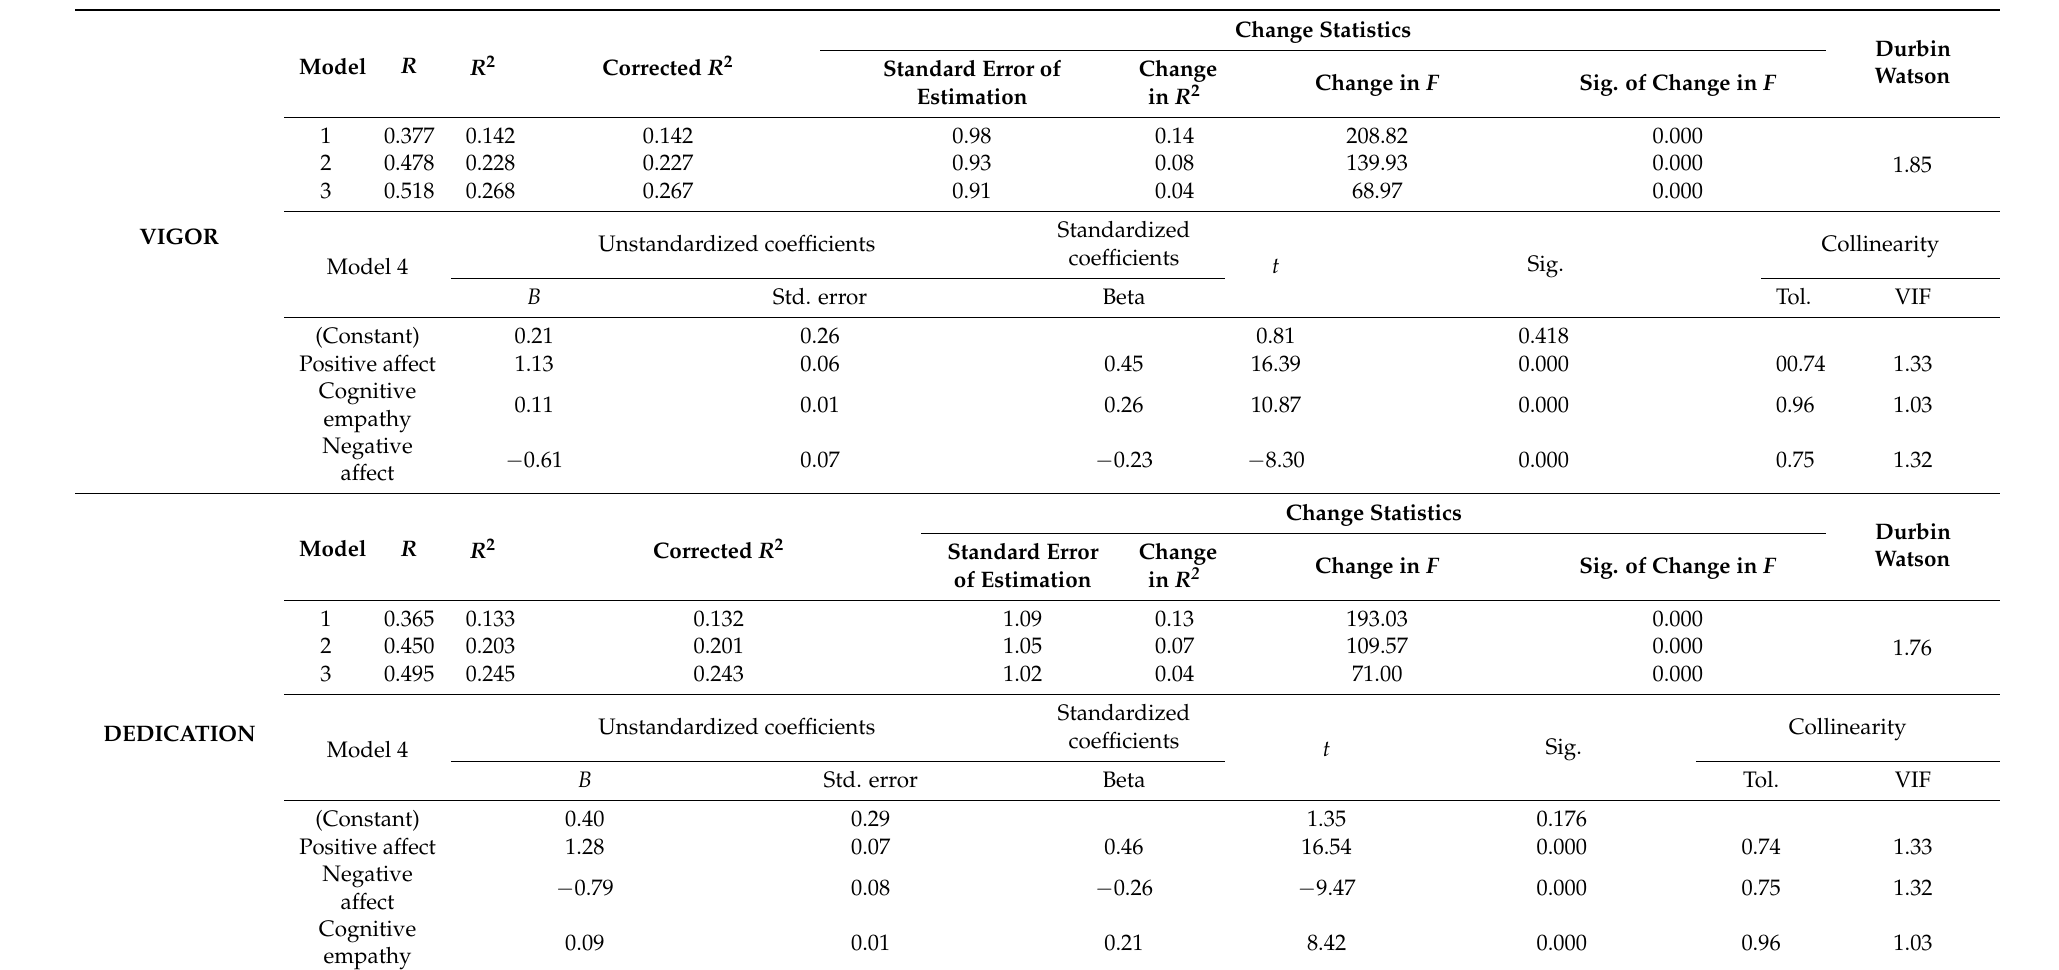
Table 2. Stepwise multiple linear regression model ( N =